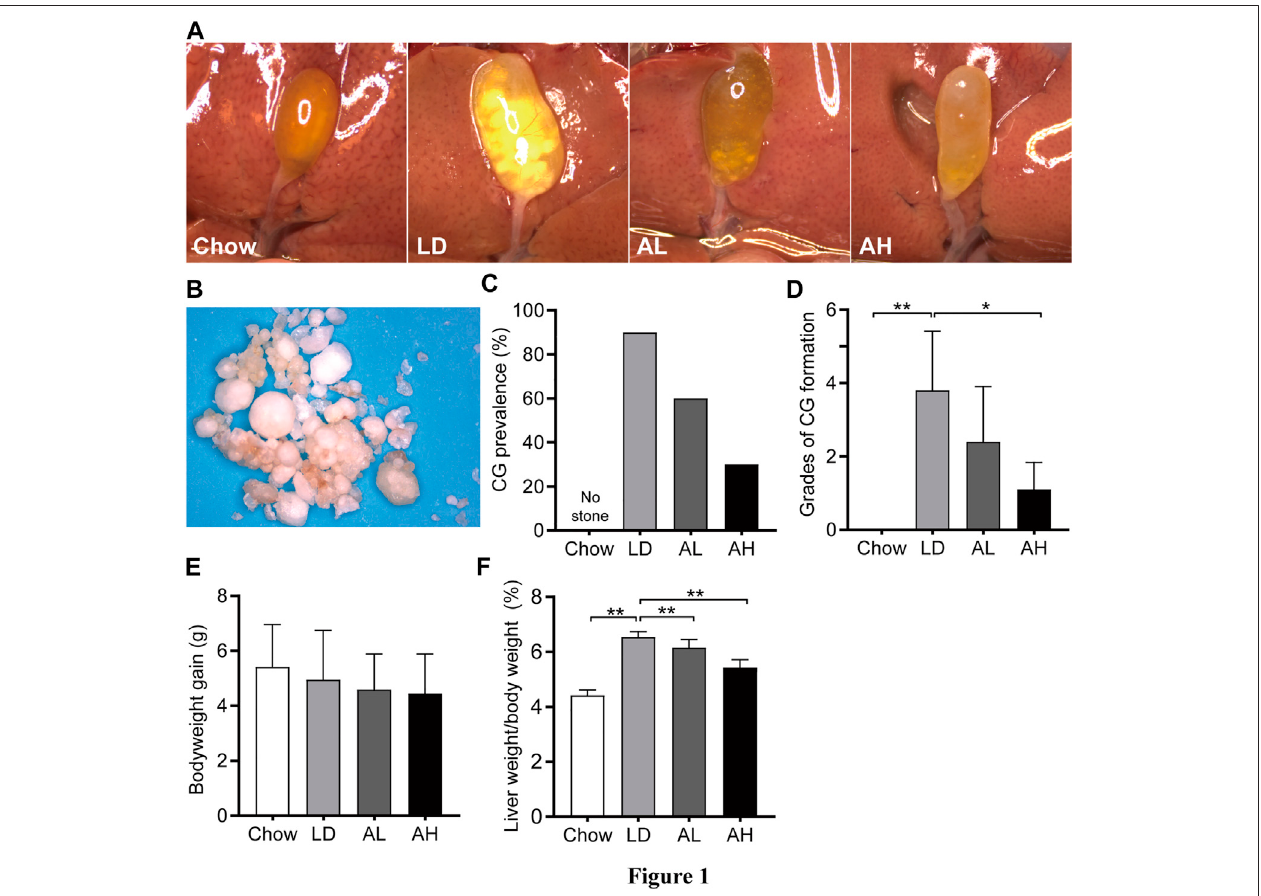
FIGURE 1 | Bodyweight, and liver weight, and cholesterol gallstone (CG) prevalence. (A) Representative gallbladders per group. (B) CGs from the LD group. (C) CGprevalence. (D) Grades ofCGformation. (E) Bodyweightgain. (F) Ratioofliverweight-to-bodyweight. Dataarethemean ± SD( n (cid:2) 10). * p < 0.05,** p < 0.01.Chow, chow diet; LD, lithogenic diet; AL, low-dose APS; AH, high-dose APS.